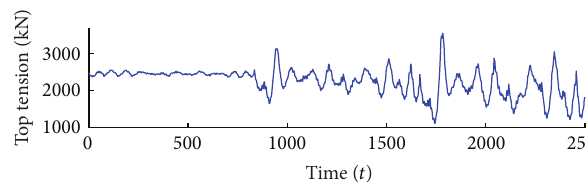
Figure 5: Tension force history used as ANN training target data.